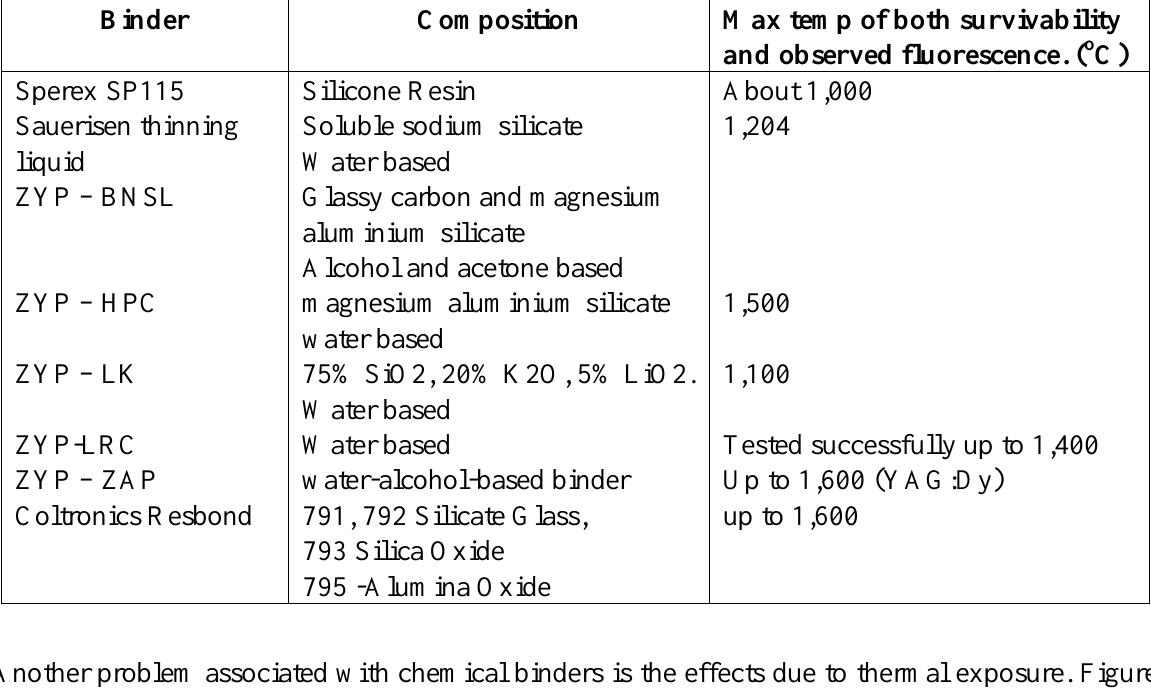
Figure 28. Left: emission spectra of Y exposure to 1,400 o C [59]. Right: Intensity of the peak emission of Y thermal exposure to 1,200 o C